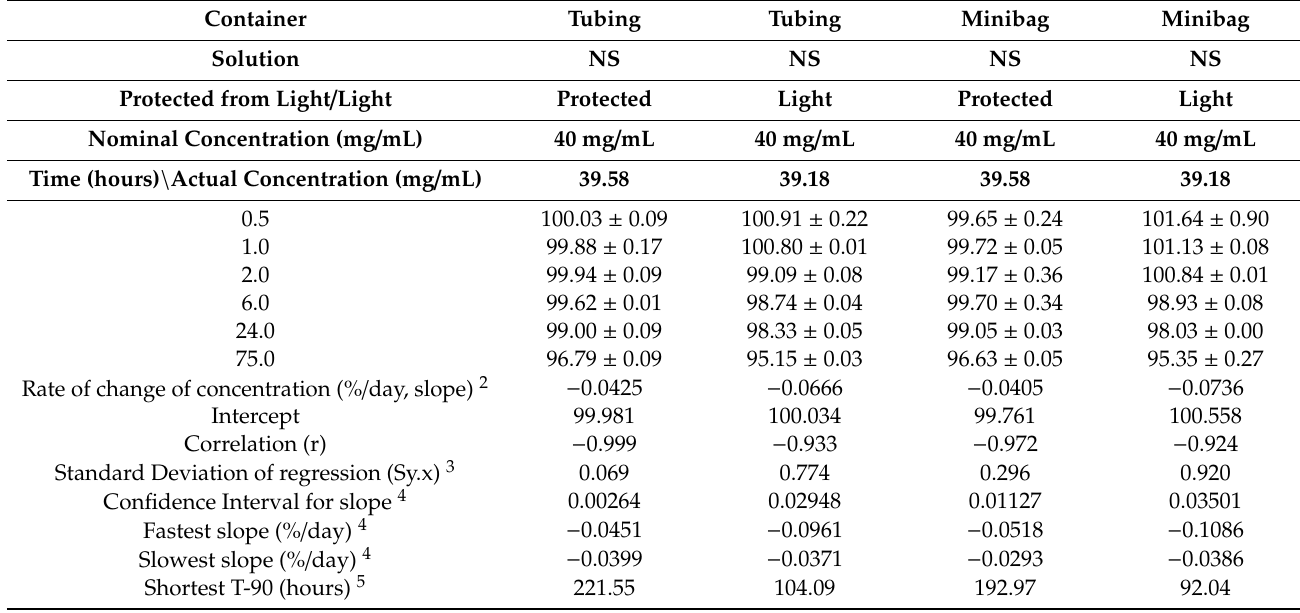
Table 3. E ff ect of light on ascorbic acid concentrations and percentage remaining 1 at each sampling time with calculation of the time to achieve 90% remaining (T-90) with 95%